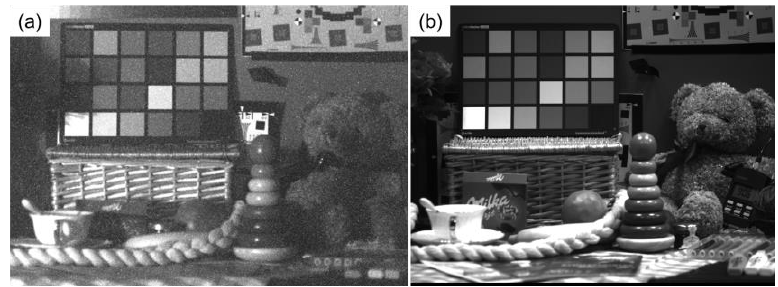
Figure 12. Photographs captured by ( a ) traditional 8T GSI and ( b ) novel 9T GSI.